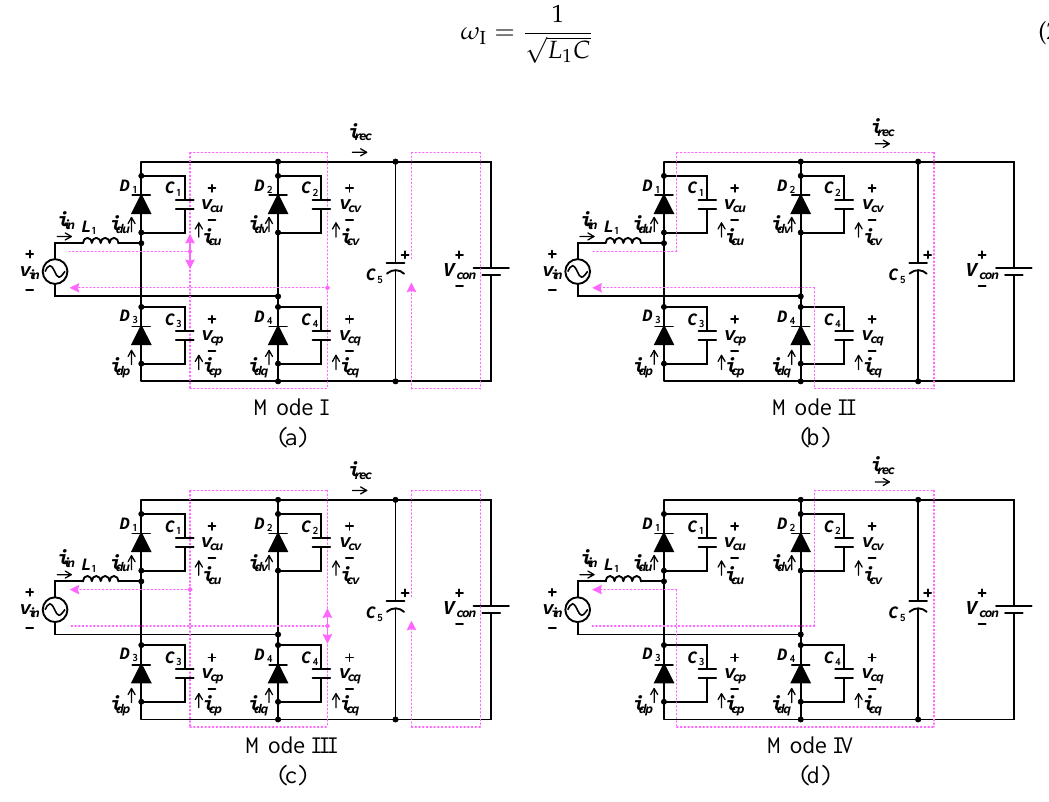
Figure 9. Operation modes of the AC-DC converter: ( a ) Mode I; ( b ) Mode II; ( c ) Mode III; ( d ) Mode